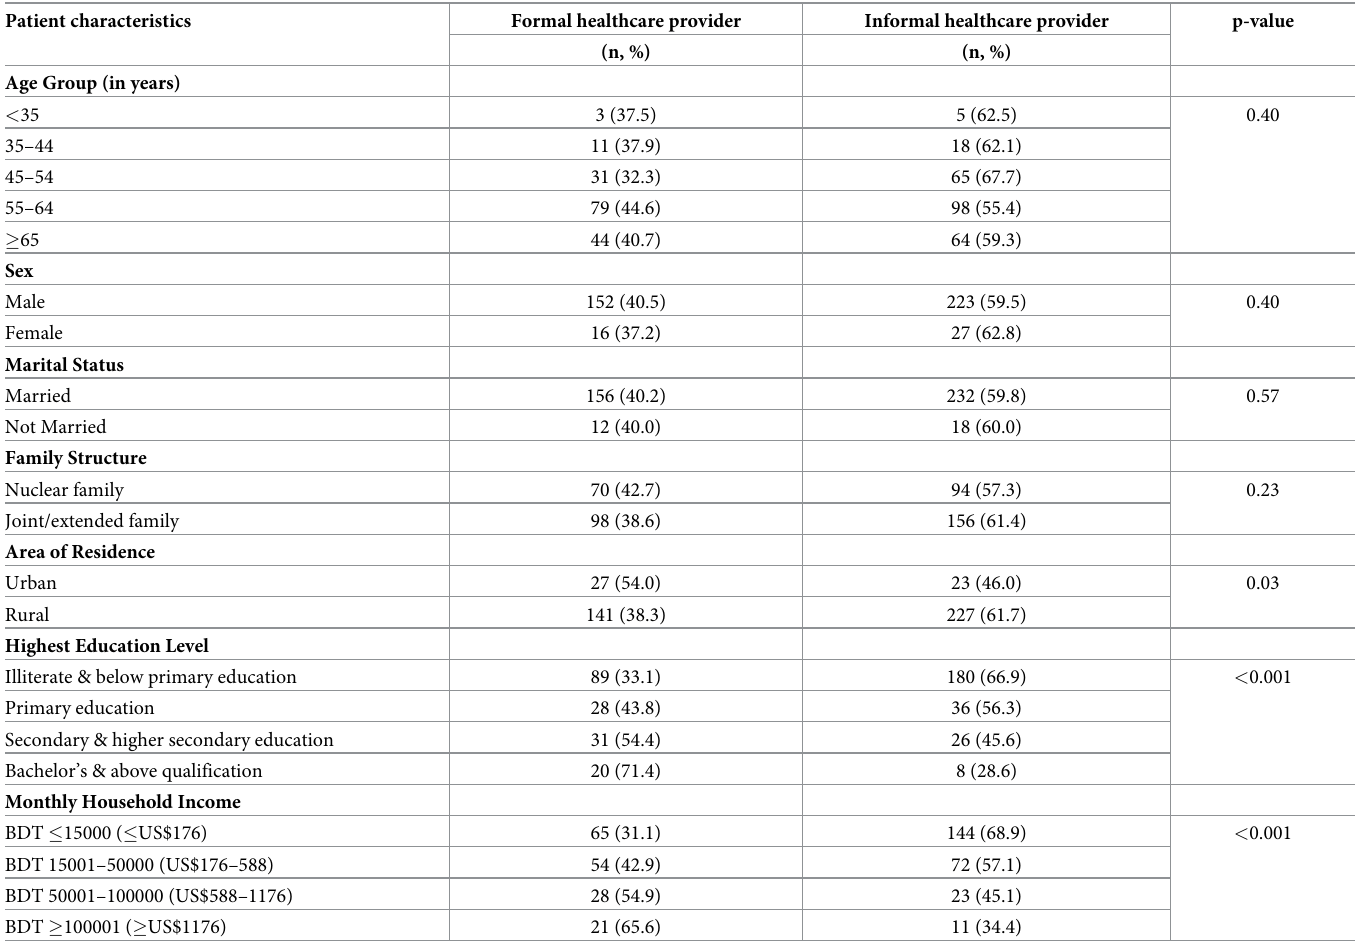
Table 5. First healthcare contact according to sociodemographic characteristics (n = 418).